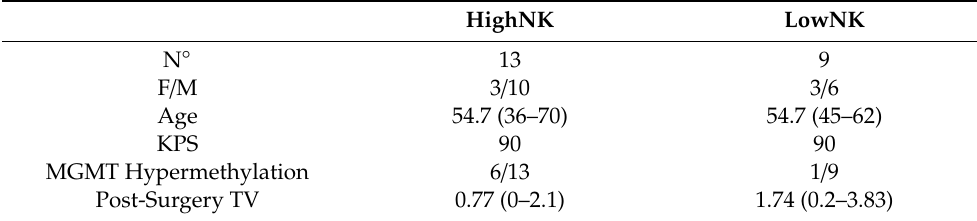
Table 1. Patients’